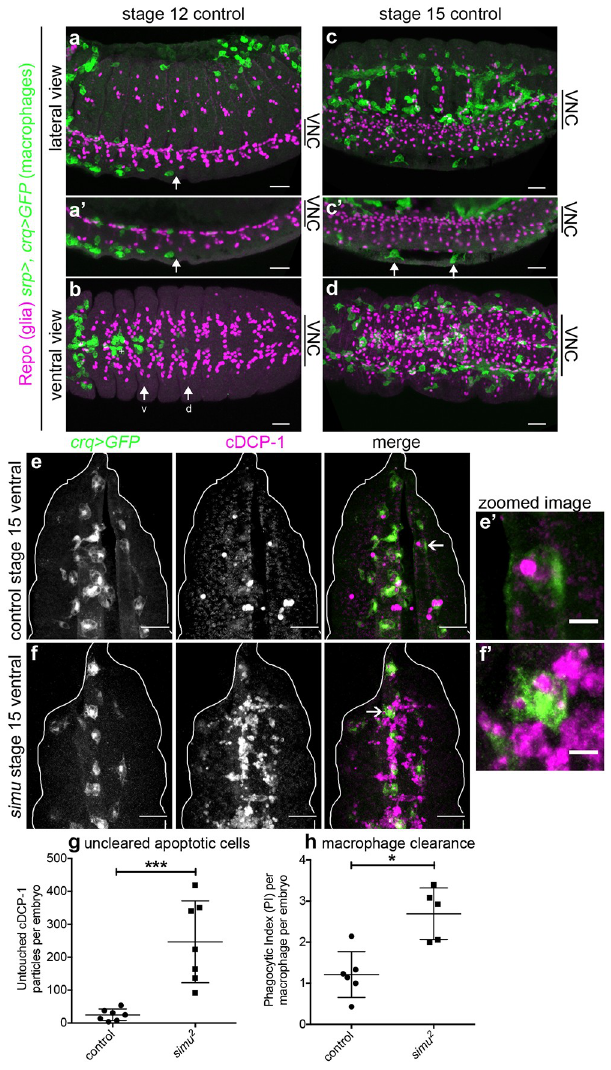
Fig 2. Loss of simu function results in exposure of macrophages to pathological levels of uncleared apoptotic cells. (a–d) Maximum projections of control embryos ( w;srp-GAL4 , UAS-GFP/+;crq-GAL4 , UAS-GFP/+ )immunostained to show close contact of macrophages (anti-GFP, green), and glia (anti-Repo, purple) at stage 12 during migration along both sides of the ventral midline (a, lateral; b, ventral) and later in development at stage 15 (c, lateral; d, ventral). (a’) and (c’) are maximum projections of a smaller number of z-slices to show position of macrophages between epidermis and and VNC. Anterior is left and arrows show pioneer macrophages; arrows ‘v’ and ‘d’ in (b) label most advanced macrophages moving along the ventral and dorsal side of the VNC, respectively; arrows in (c’) show two macrophages between VNC and epidermis. (e–f) Maximum projections of stage 15 control and simu mutant embryos showing macrophages (GFP, green in merge) and apoptotic particles (cDCP-1, purple in merge), respectively. Projections are ventral views and correspond to void between epidermis and VNC. (e’–f’) Show zooms of macrophages indicated by arrows in (e–f); white line shows edge of embryos. (g) Scatterplot of untouched apoptotic punctae (cDCP-1 punctae not in contact with macrophages in the field of view) per embryo in control and simu mutant embryos at stage 15 ( n = 7 per genotype; P = 0.0006, Mann–Whitney test). (h) Scatterplot of phagocytic index (cDCP-1 punctae engulfed per macrophage, per embryo) in control and simu mutant embryos at stage 15 ( n = 6 and 5 embryos, respectively; > 10 cells analysed per embryo, 96 and 64 macrophages analysed in total, respectively; P = 0.017, Mann–Whitney test). Genotypes in (e–h) are w;;crq-GAL4 , UAS-GFP (control) and w;simu 2 ; crq-GAL4 , UAS-GFP ( simu mutants). Error bars represent mean ± standard deviation; � and ��� denote P < 0.05 and P < 0.001; scale bars represent 10 μ m (a–d), 20 μ m (e–f), and 5 μ m in zoomed panels (e’–f’). All data used to plot graphs may be found in Supporting information file S1 Data. cDCP-1, cleaved death caspase 1; GFP, green fluorescent protein; UAS, upstream activating sequence; VNC, ventral nerve cord.